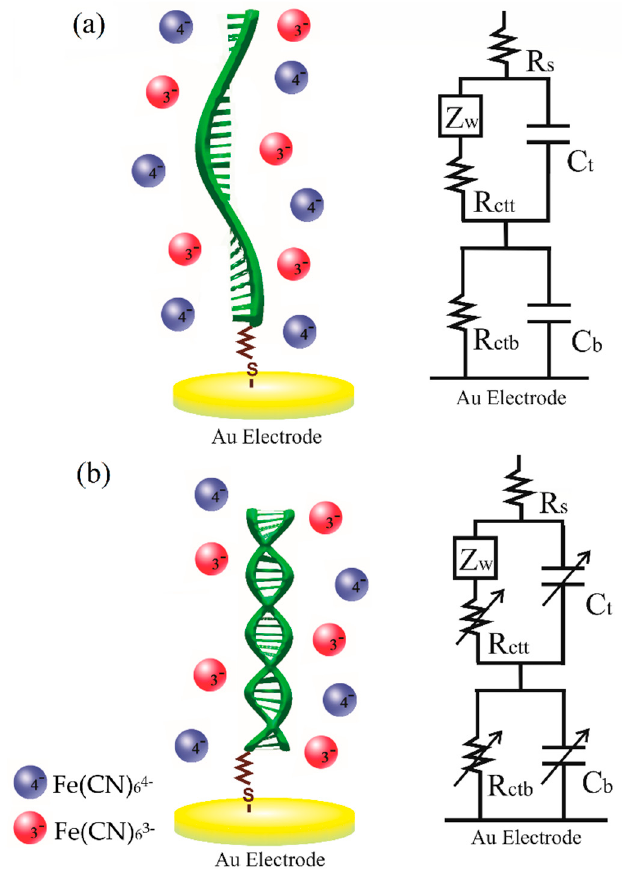
Figure 5. Illustration of DNA–redox couple interaction and the proposed equivalent circuit (EC): ( a ) ssDNA and ( b ) dsDNA. The arrows indicate the circuit elements that change when hybridization occurs.